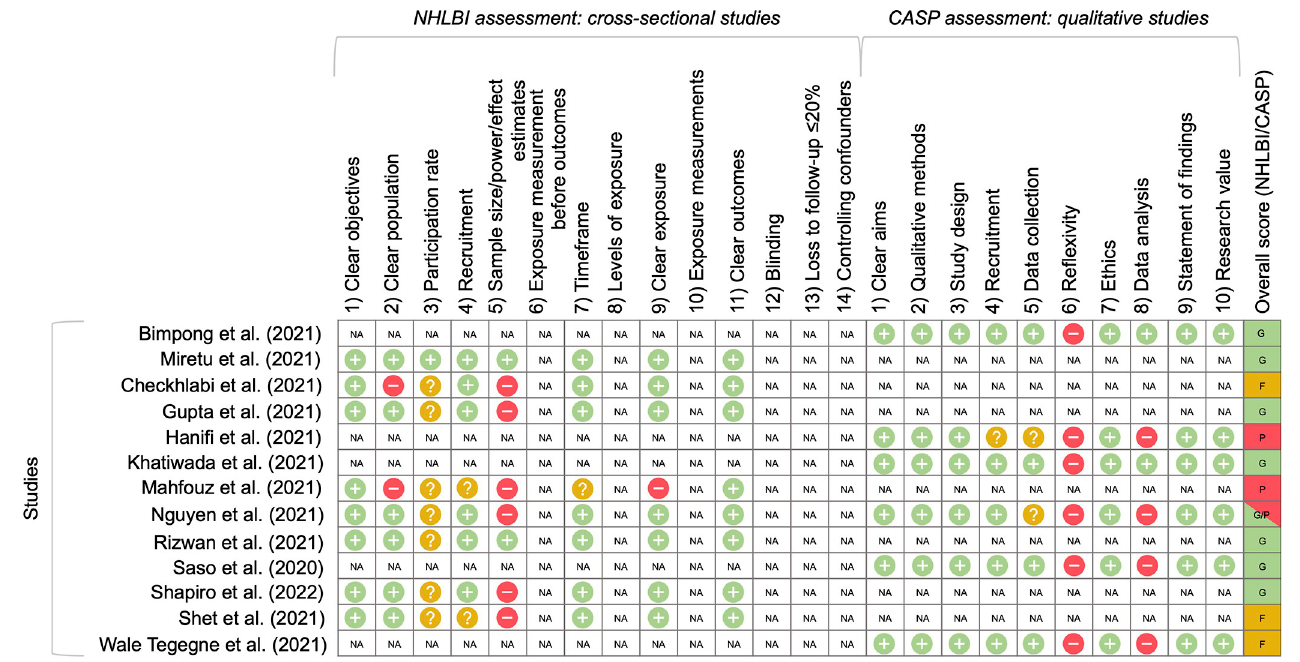
Fig 2. Results of quality assessment for included studies, following NHLBI and CASP assessments criteria, where (+) denotes that a criterion was met, (-) denotes that it was not met, (?) denotes that it was unclear from the manuscript and supplementary materials, and N/A denotes the criterion was not applicable to the study. [Overall scores: good (G), fair (F), poor